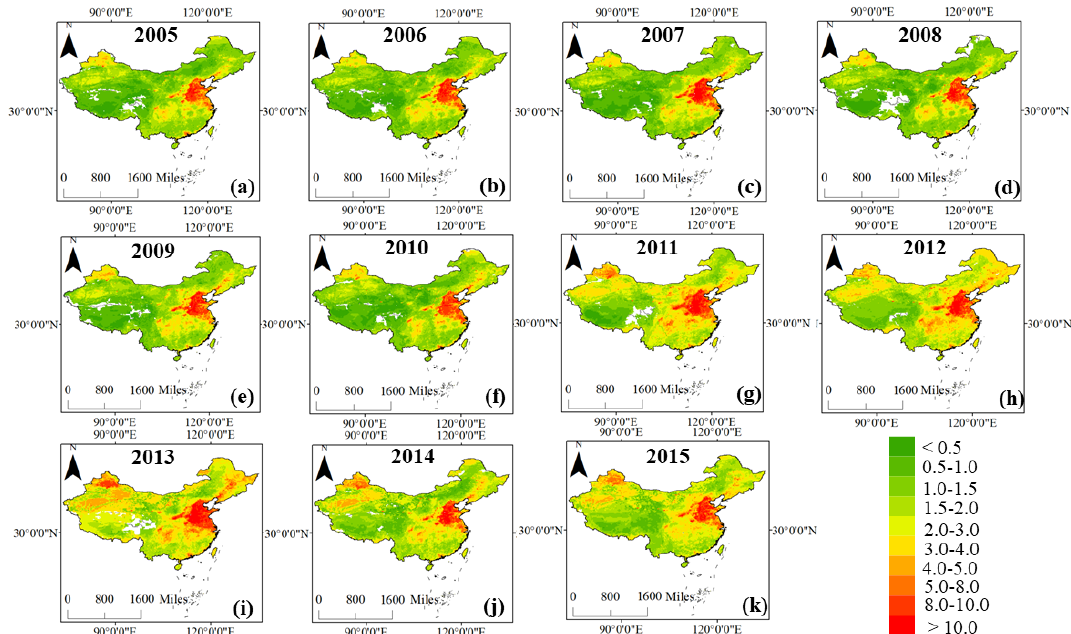
− concentrations (µgNm − 3 ) across the entire study area from (a–k) 2005–2015 based on the 3